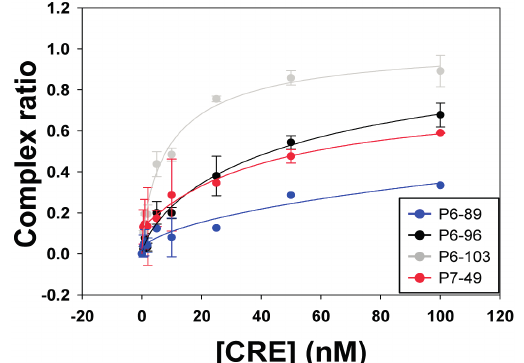
Figure 4. Binding assays of the aptamers P6-86, P6-96, P6-103, and P7-49 to the HCV CRE region. Graph shows the titration curve corresponding to the binding assays performed with the different aptamers under study. Internally 32 P-labeled transcripts encompassing each of the tested aptamers were challenged with increasing amounts of their unlabeled interacting partner HCV-CRE 194 . Experiments were repeated at least three times and data were fitted to a non-linear equation for the calculation of the K d